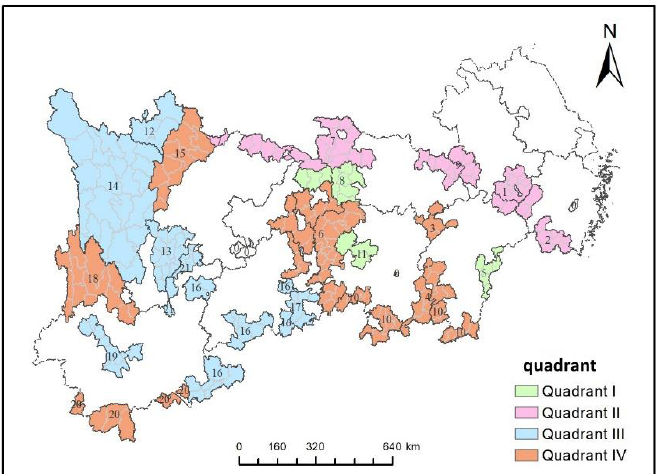
Figure 8. Mapping for categorization of National Key Ecological Function Areas in the Yangtze River Economic Belt. The numbers in the figure represent 21 NKEFAs, which are the same as those in Figure